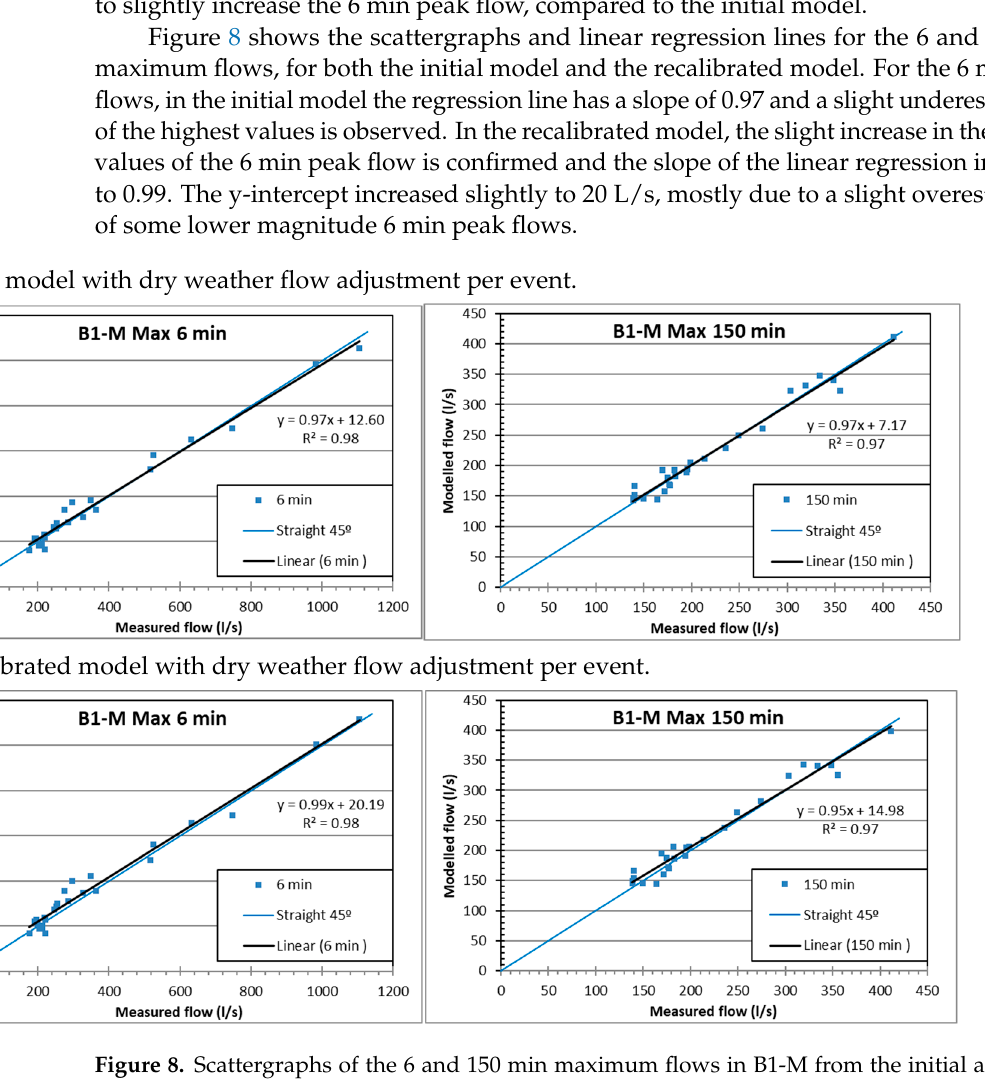
Figure 8. Scattergraphs of the 6 and 150 min maximum flows in B1-M from the initial and recalibrated models. brated